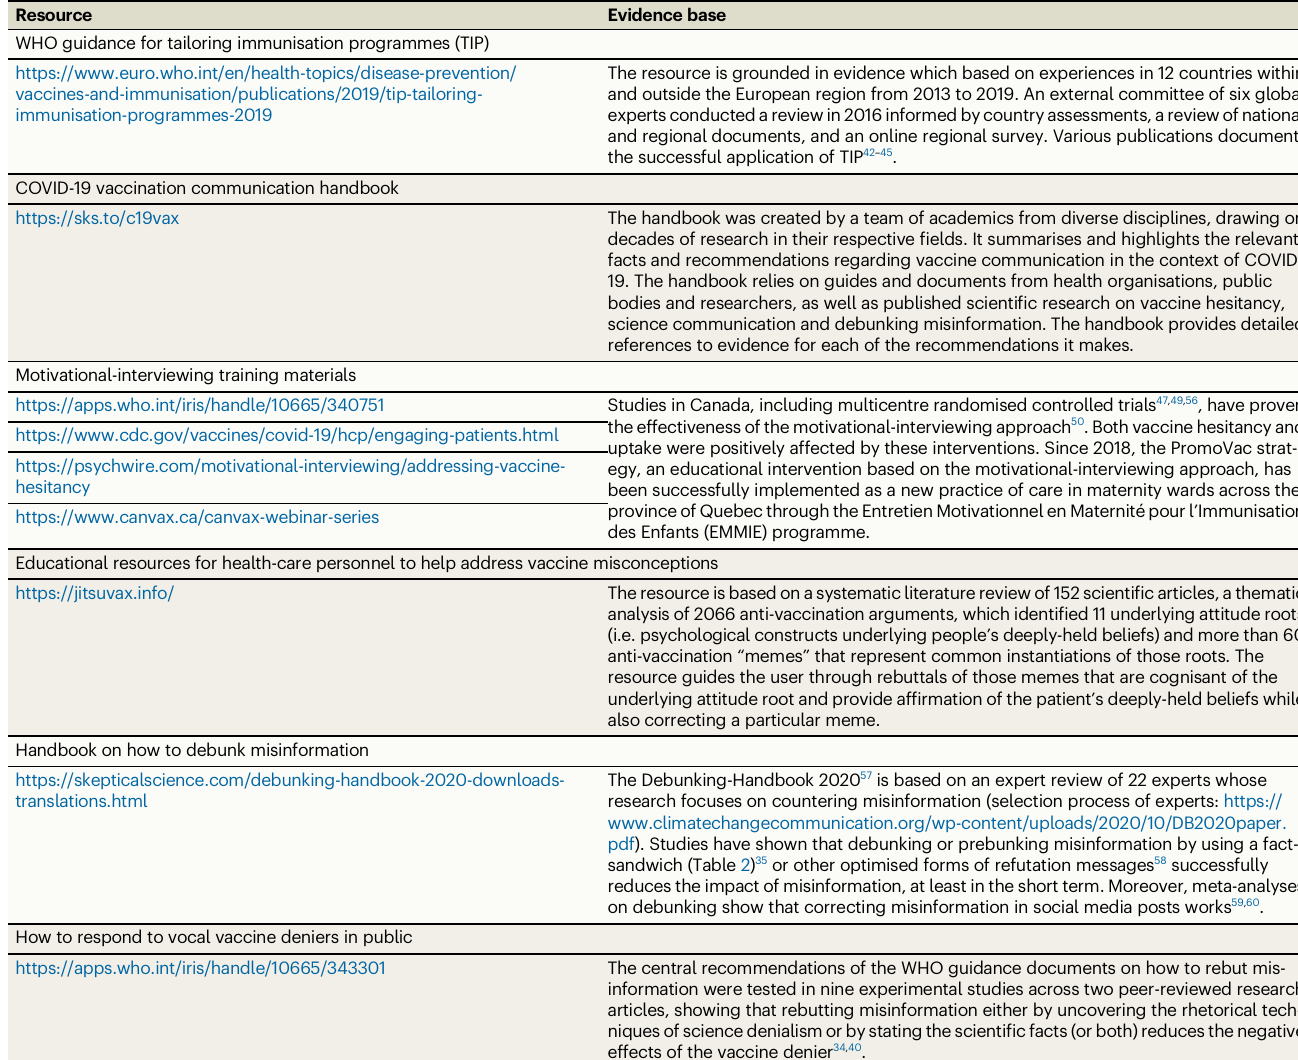
Table 1 | Overview of resources: Descriptions of resources in the text